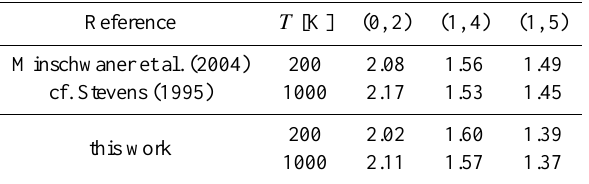
Table 2. NO band integrated emission rate factors (in 10 − 6 phs − 1 ) at 200 and 1000K for the γ bands used in the retrieval. Top row: re- sults from Stevens (1995), using the parameters from Piper and Cowles (1986), and used for NO retrieval by Minschwaner et al. (2004). Bottom row: factors used in this work, using the parameters from Luque and Crosley